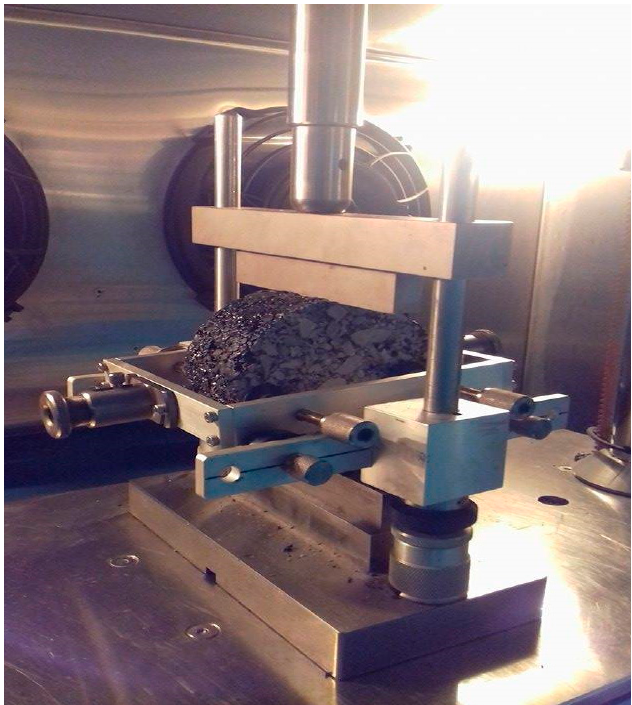
Figure 8. The ITFT load assembly.